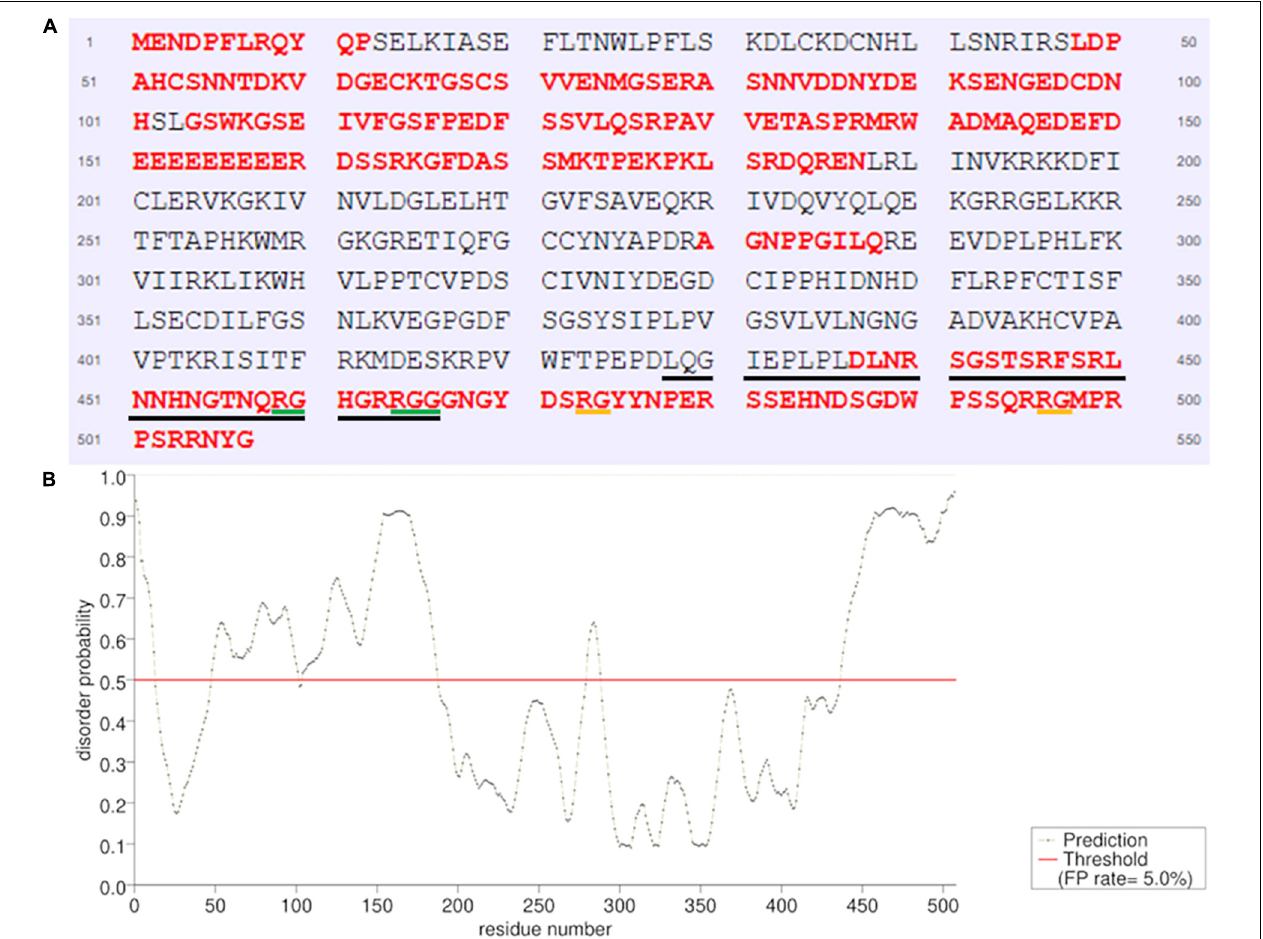
FIGURE 4 | Prediction of natively disordered regions of at ALKBH9B using PrDOS. (A) at ALKBH9B amino acid sequence with disordered residues in red. The RBD located between positions 427–467 is underlined (black line). RGxxxRGG motif is underlined in green and the two extras RGs are in orange. (B) Disorder profile plot. Prediction false positive rate: